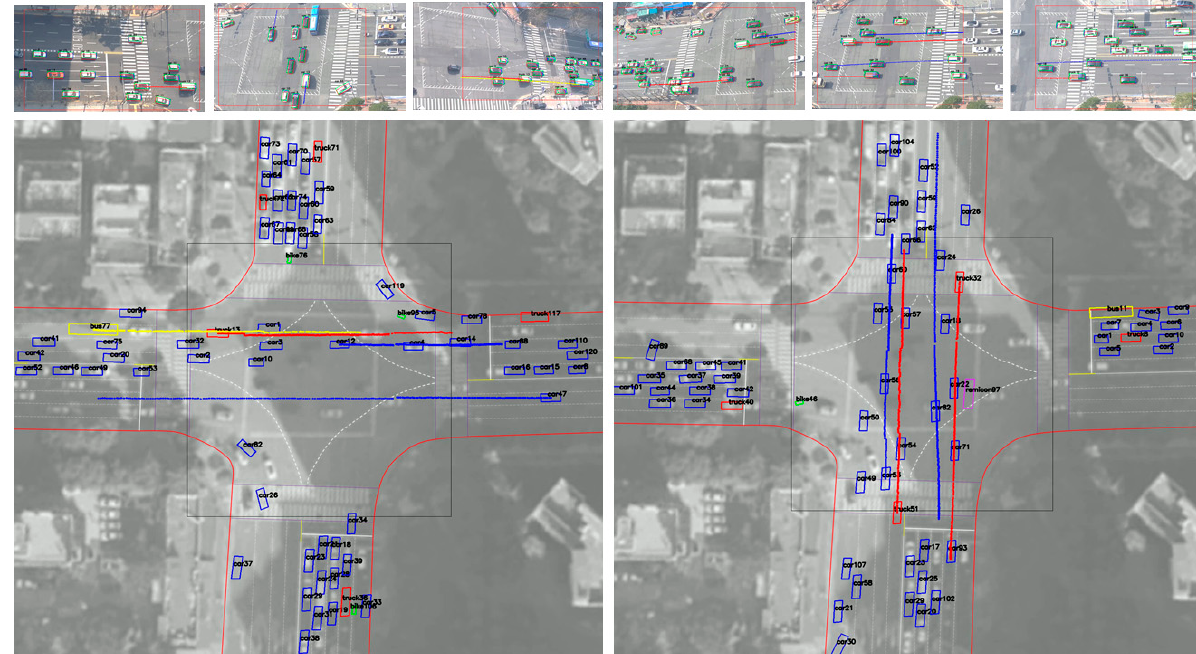
Figure 13. Examples of vehicle trajectories: driving straight (left and right) ( left ); driving straight (up and down) ( right ).